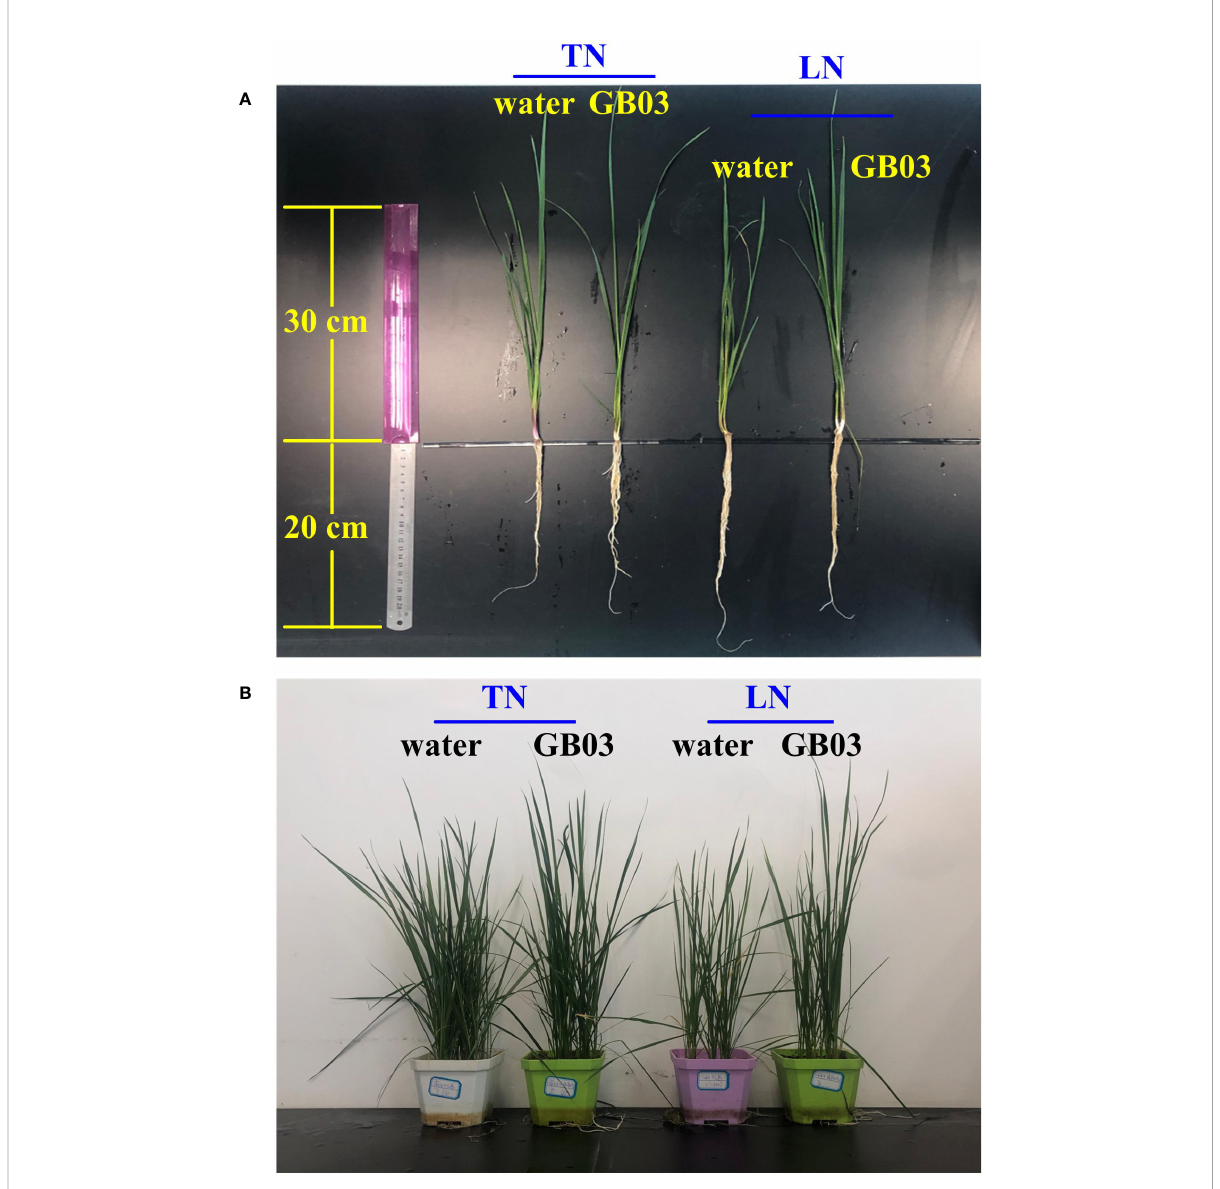
FIGURE 1 Effects of GB03 on tall fescue phenotype. (A) Individual plant and (B) one pot of plant (containing fi ve seedlings) were photographed from different parallel treatments, including the total nitrogen level (TN-3.75 mM NO 3- ) and the low nitrogen level (LN-0.25 mM NO 3- ) with GB03, respectively, and the water treatment as